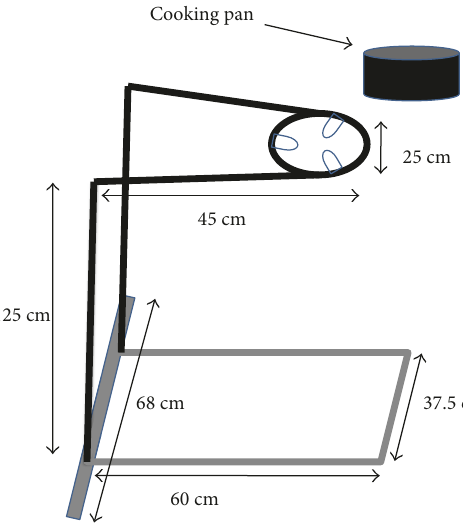
Figure 6: Cooking pan holding frame.